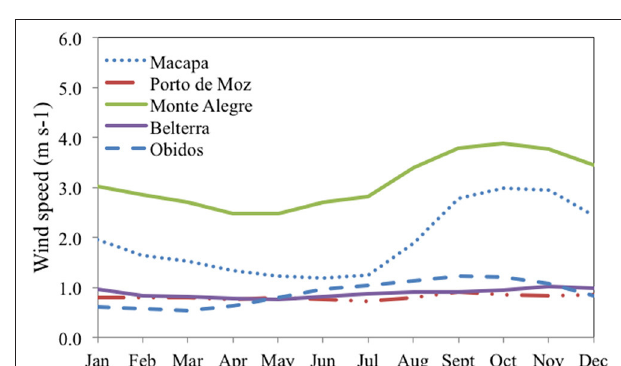
FIGURE 5 | Seasonal variation of k 600 for the mainstem and tributaries.